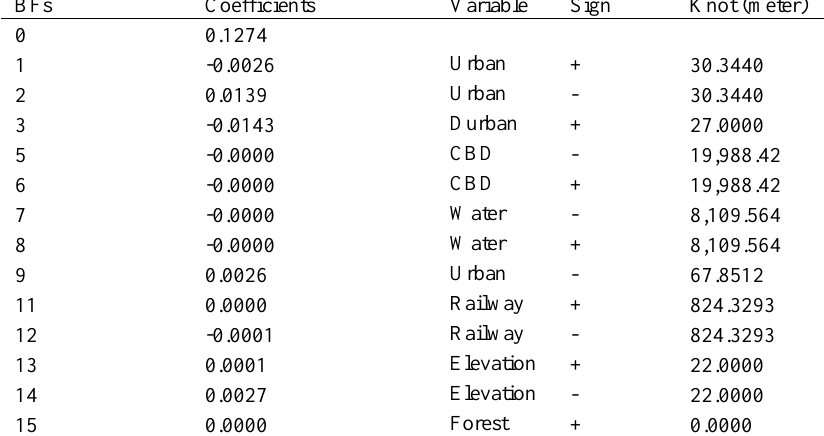
Table 3. Coefficients, variables and knots of MARS in the study area